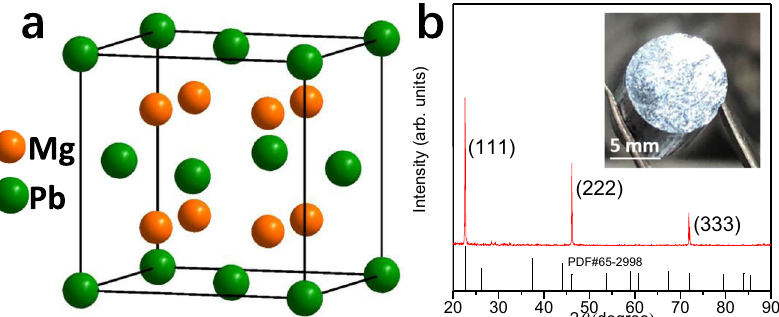
Fig. 3 Characterization of Mg 2 Pb. a Crystal structure of Mg 2 Pb. b X-ray diffraction pattern to the cleavage surface of the (111) plane of the Mg 2 Pb crystals. Inset: a typical photograph.